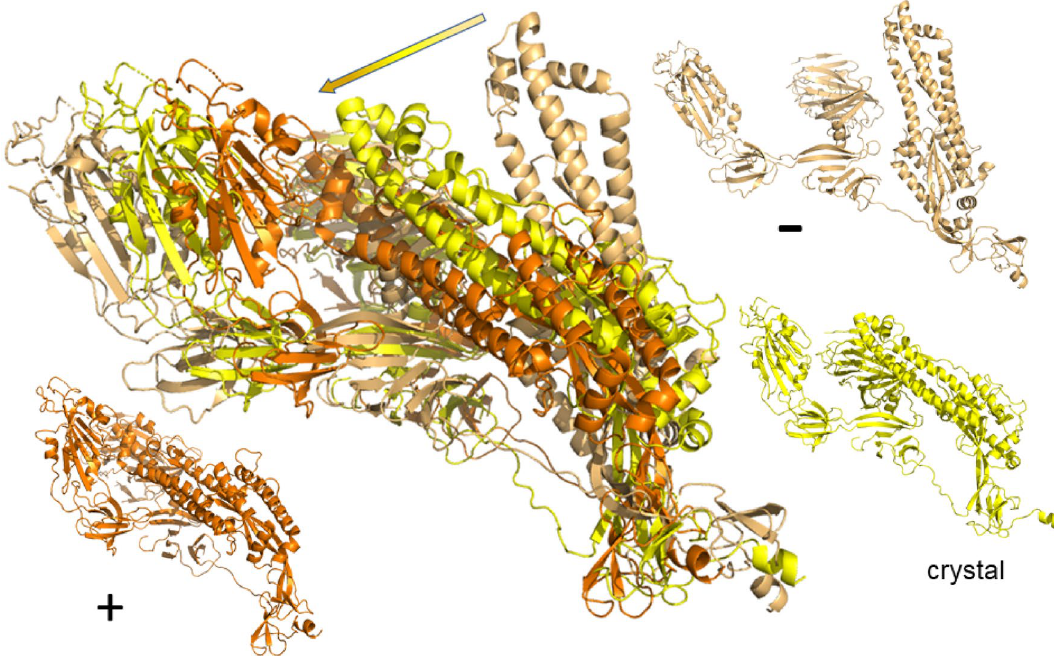
Figure 3. Example of flexible motion for mode m 7 of the SARS-CoV-2 spike ecto domain (PDB: 6vxx) monomer at E cut = 0.5 kcal/mol with chain A denoted by yellow with its extreme structural positions superimposed and colored light orange/orange. The arrow indicates the range of movement for the dominant α -helix structure in the spike ecto domain, from negative to positive movement. The smaller protein structures surrounding the large one show the initial (crystal) structure as well as the extremes ( + , –) along the possible motion directions for m 7 in the same colors as in the superimposed